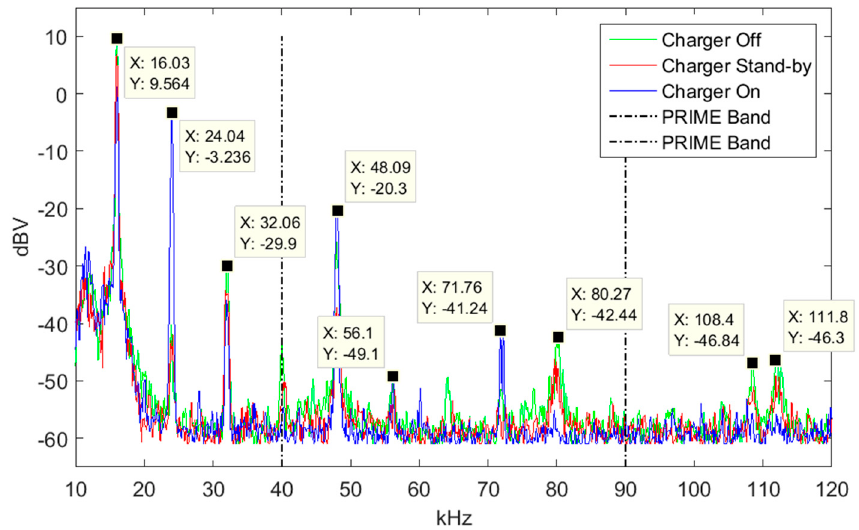
Figure 25. Spectrum recorded at PV3 SM for different states of the battery charger with the inverters switched on.